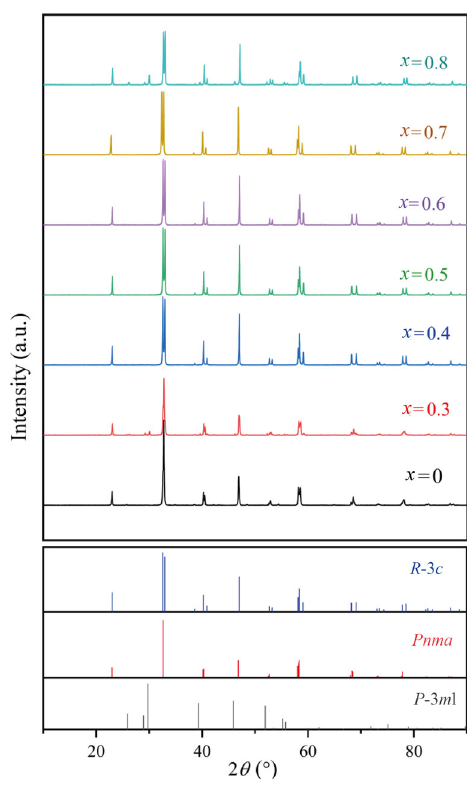
Fig. 1 XRD patterns of La(CoCrFeMnNiAl x ) 1/(5+ x ) O 3 − δ